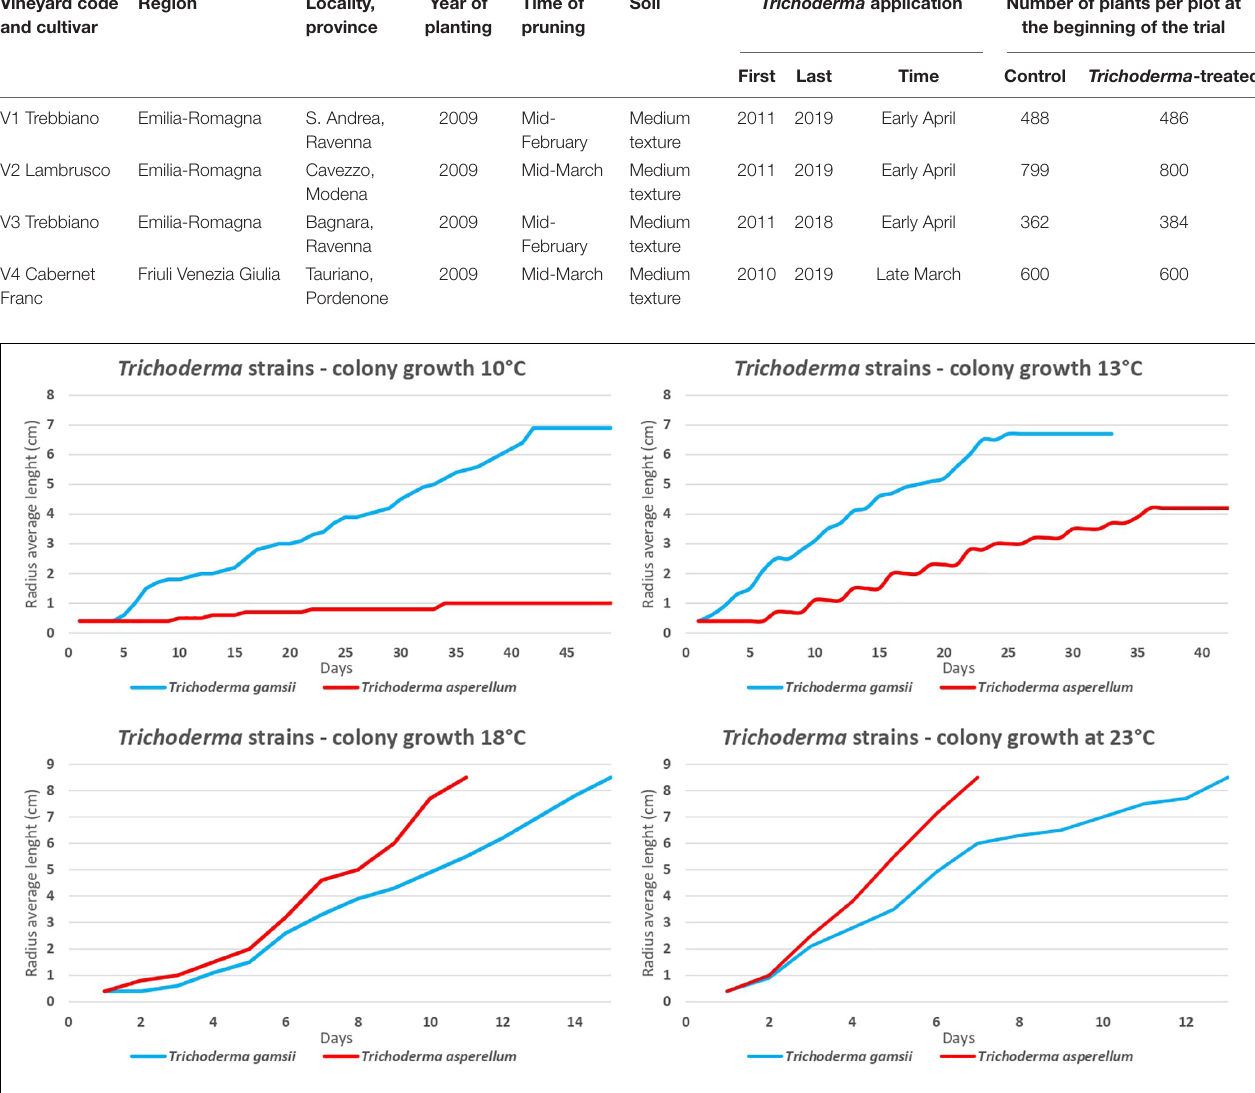
over time). In both trials, 6 wood chips per cane, taken from the first 5 mm of the cut end in each trimming cut, were plated on MA. Colonization and persistence were evaluated as the number of canes with at least one colony (incidence) and as the total number of wood chips colonized by each of the two Trichoderma species